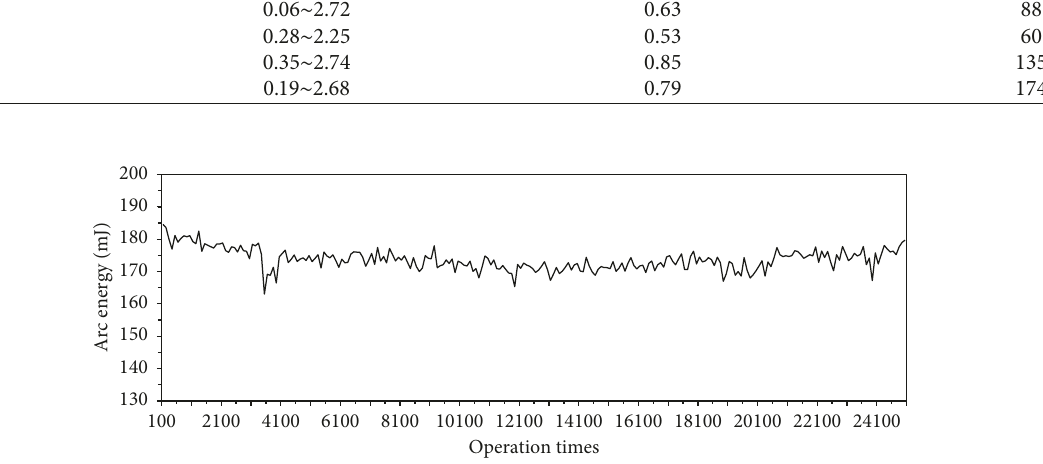
Figure 6: The arc energy of Ag-SnO 2 /La 2 O 3 contact material with 50nm doped particle